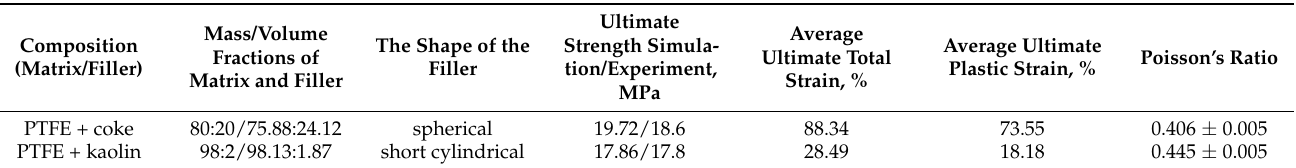
Figure 15. Equivalent stresses according to von Mises stress ( a ) and residual (plastic) relative linear strains ( b ) for composite with short cylindrical filler at the moment of full compression (second stage).